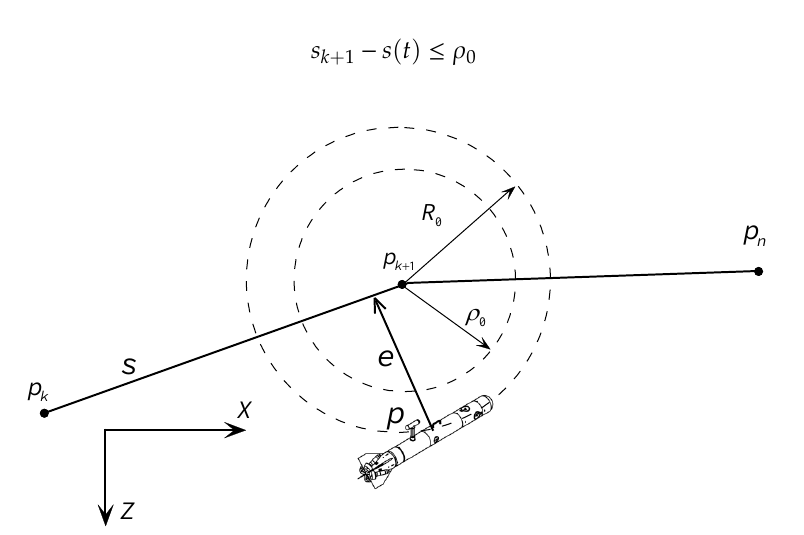
Figure 12. Waypoint selecting criterion with along-track distance.